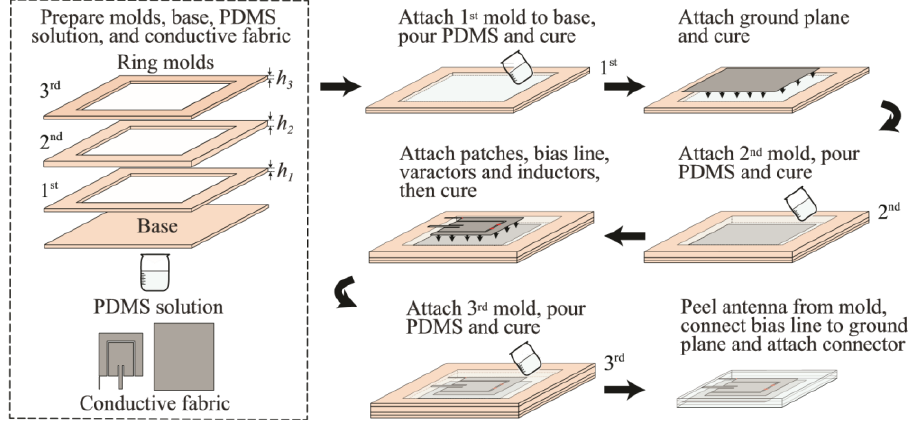
Figure 6. Manufacturing process flow for embedding fabrics in PDMS. Table 3. Examples for embedded antennas.